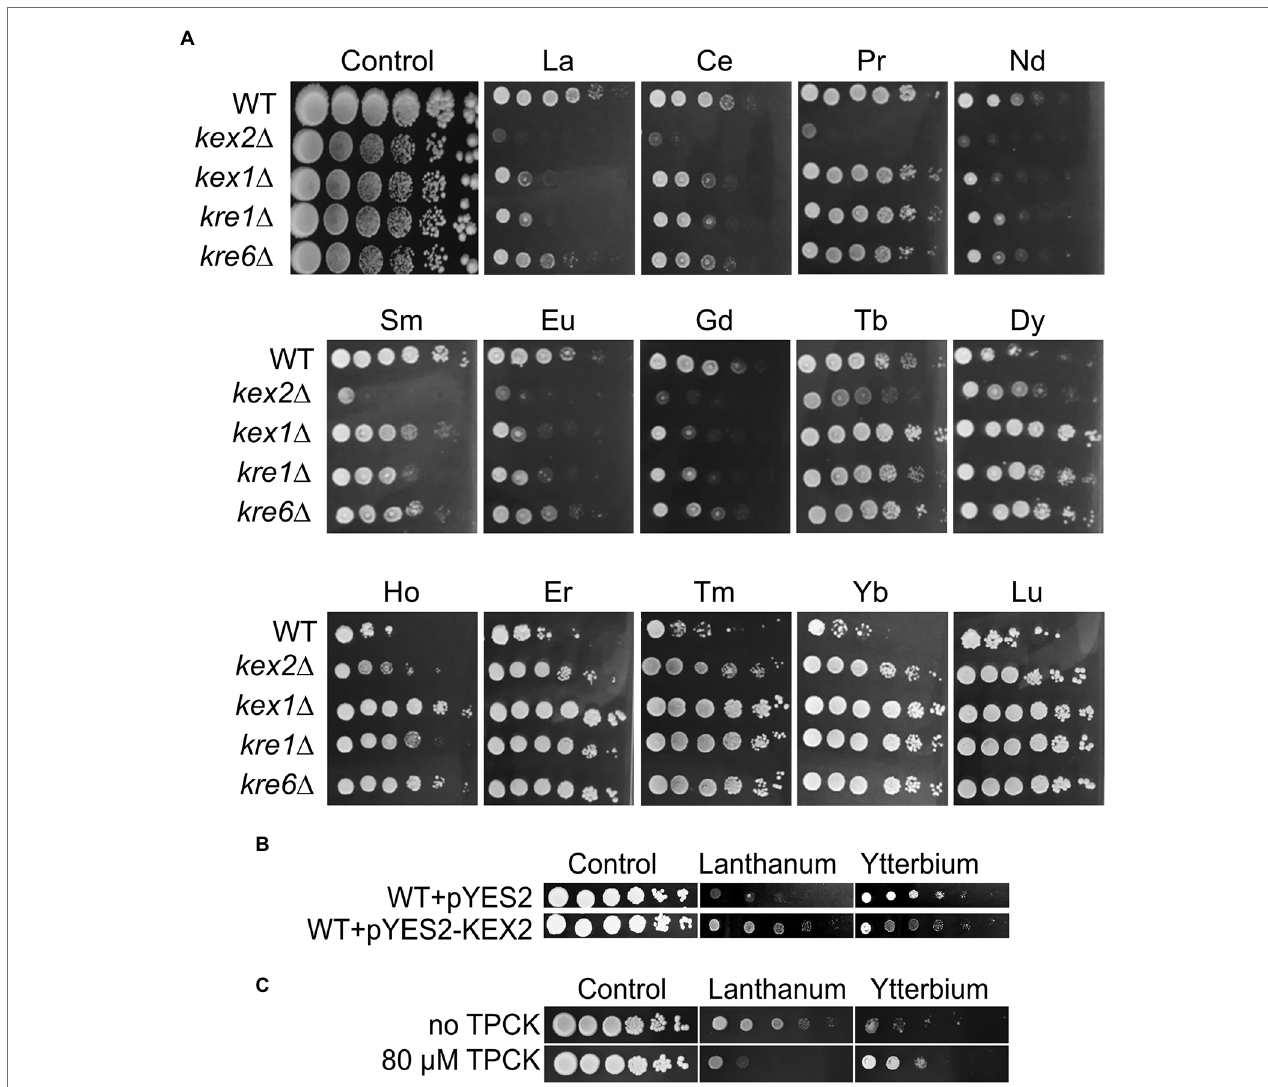
FIGURE 5 | Growth of Kex and Kre mutants and effects of Kex2p overexpression or TPCK supplementation on yeast growth under Ln exposure. (A) Yeast growth was assessed on YPD medium without lanthanides (control) or supplemented with 4.0 mM La, 3.8 mM Ce, 5.8 mM Pr, 4.2 mM Nd, 3.9 mM Sm, 3.9 mM Eu, 3.8 mM Gd, 3.8 mM Tb, 3.6 mM Dy, 3.9 mM Ho, 3.9 mM Er, 3.6 mM Tm, 3.6 mM Yb, or 3.6 mM Lu, with 10-fold serial dilutions of cultures from left to right in each panel. A representative plate (out of 3 independent experiments) is shown. Plates were incubated for 5 days at 28 ° C. (B) Overexpression of Kex2p confers resistance to La but sensitivity to Yb. Yeast cells were transformed with the empty plasmid (pYES2) or with the same plasmid harboring KEX2 (pYES2-KEX2). Cells were grown on YPG in the presence of either La (3.8 mM) or Yb (3.2 mM) or in the absence of Ln (control), and 10-fold serial dilutions were plated on YPD media. (C) Drop test of 3-fold serial dilutions of the WT strain exposed to La (3.8 mM) and Yb (3.2 mM) with the addition of the serine protease inhibitor tosyl phenylalanyl chloromethyl ketone (TPCK). Representative pictures (out of 3 independent experiments) are